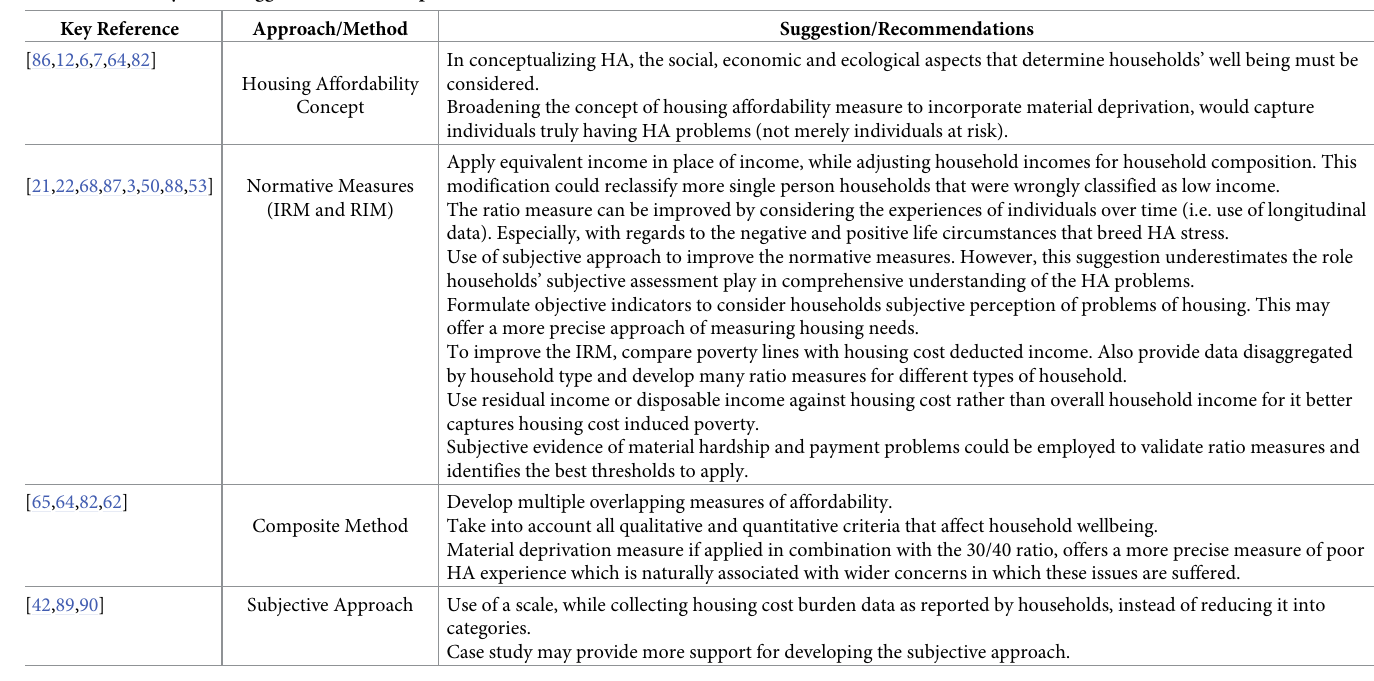
Table 4. Summary of the suggestions for the improvement of selected